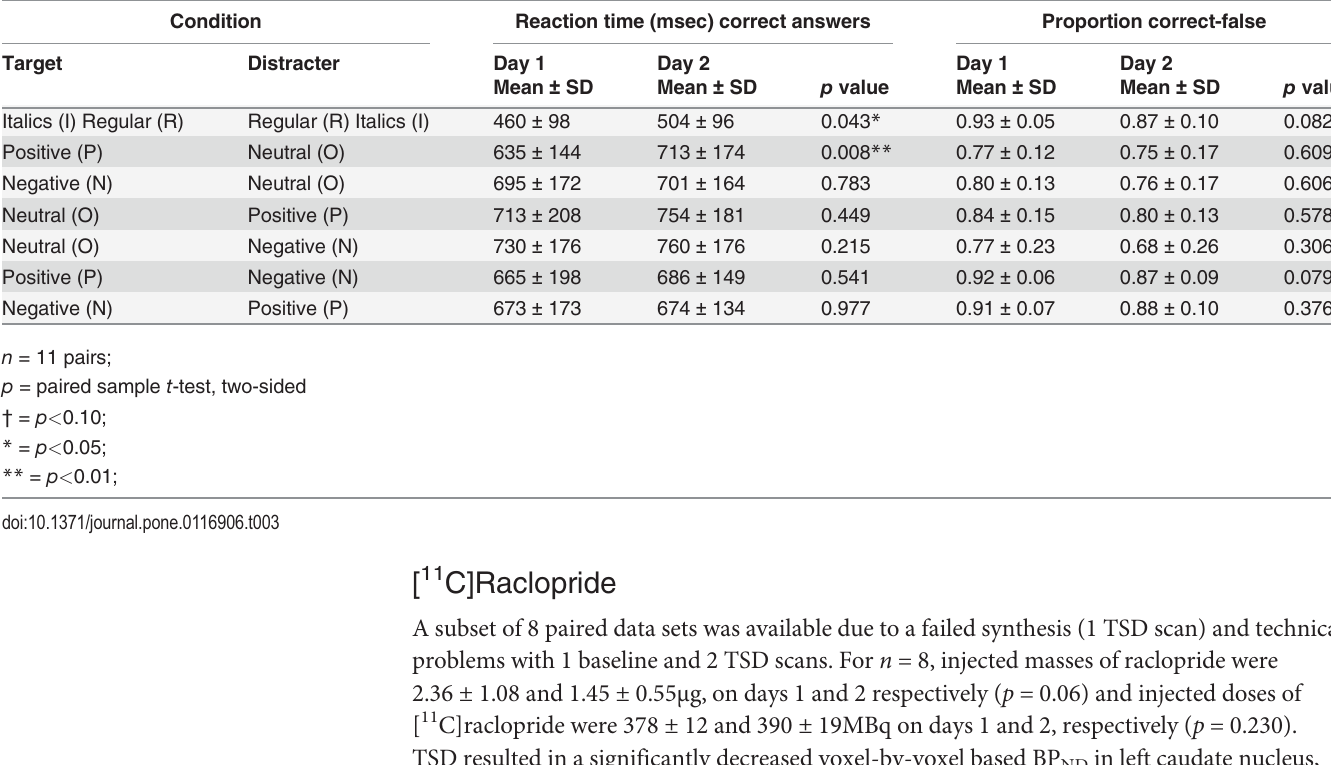
Table 3. fMRI task